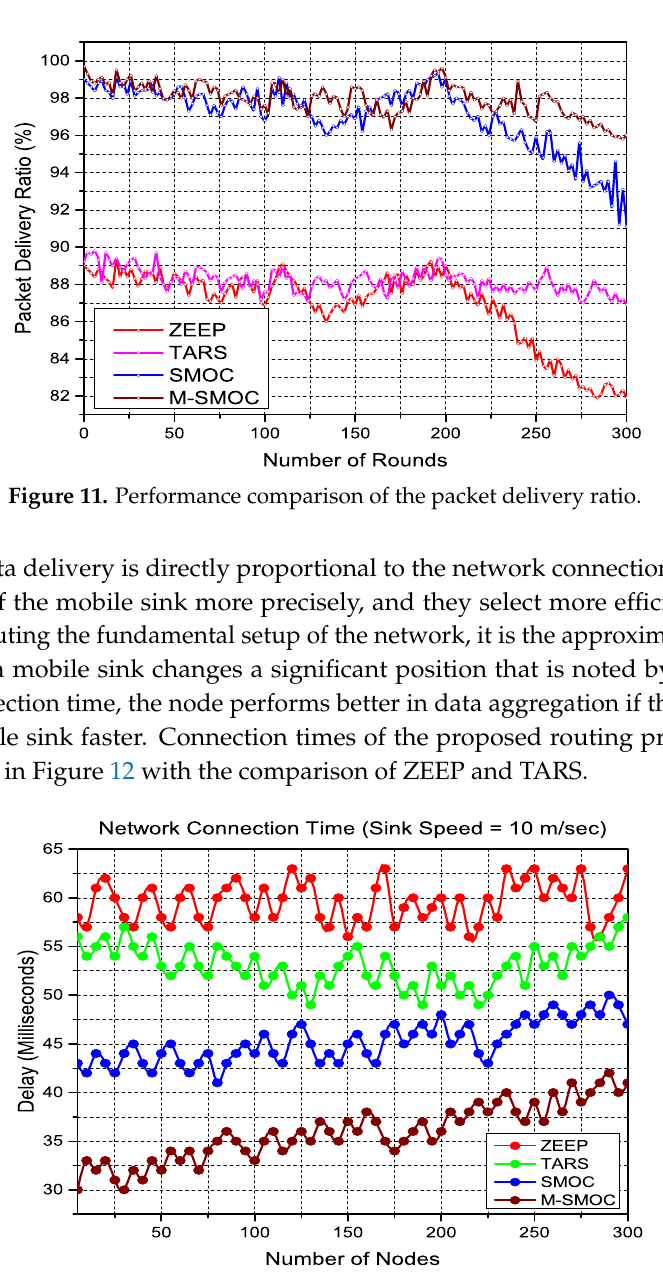
Figure 12. Comparison of the network connection time with various sizes of the